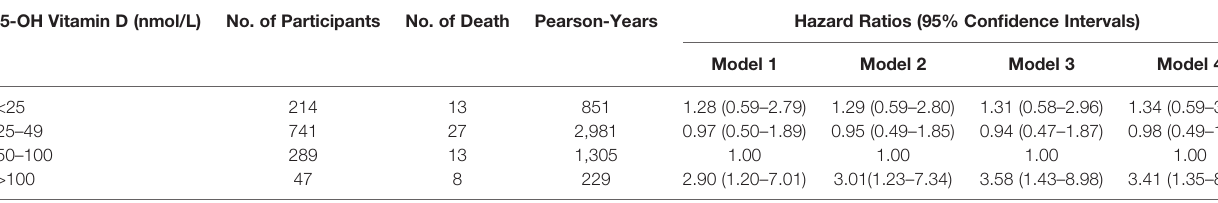
TABLE 4 | Hazard ratios of all-cause mortality by different levels of 25-OH vitamin D levels among patients with type 2 diabetes. 25-OH Vitamin D (nmol/L) No. of Participants